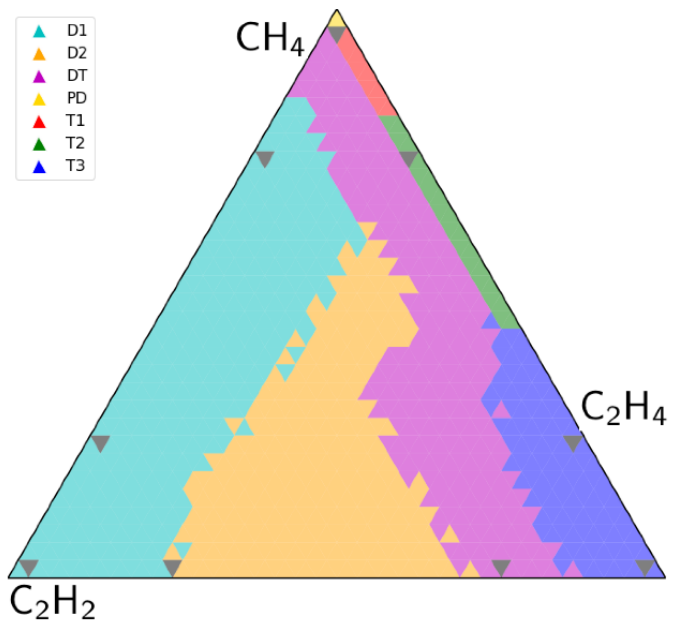
Figure 12. Duval’s triangle and associated faults. Adapted from [49], licensed under CC BY 4.0.